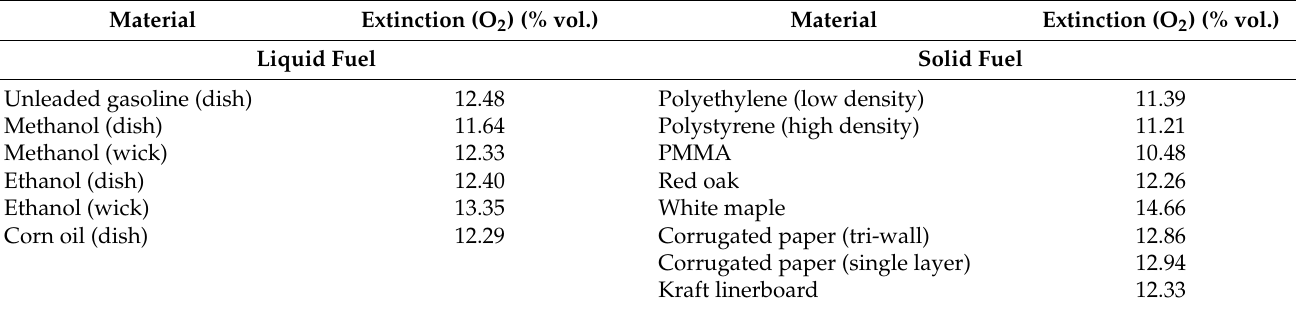
Table 1. Limiting oxygen concentration at fire extinction